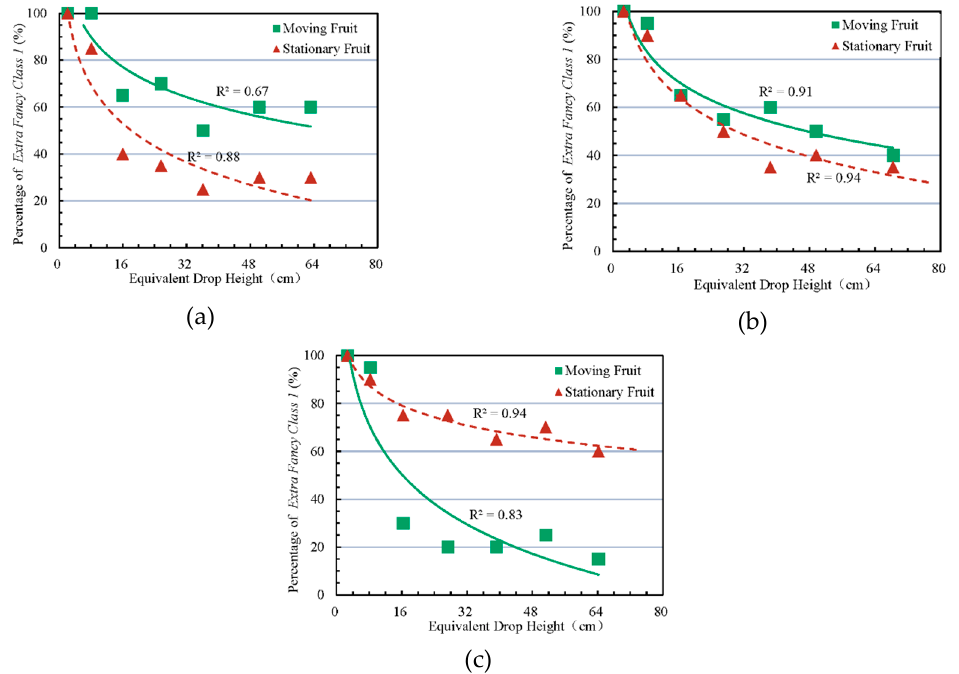
Figure 4. Percentages of Extra Fancy Class 1 grade fruit with increasing equivalent drop height for free apple-to-apple impact in ( a ) middle-to-top, ( b ) middle-to-middle, and ( c ) middle-to-bottom impact patterns. Logarithmic curves were fitted separately for stationary and moving fruit samples.